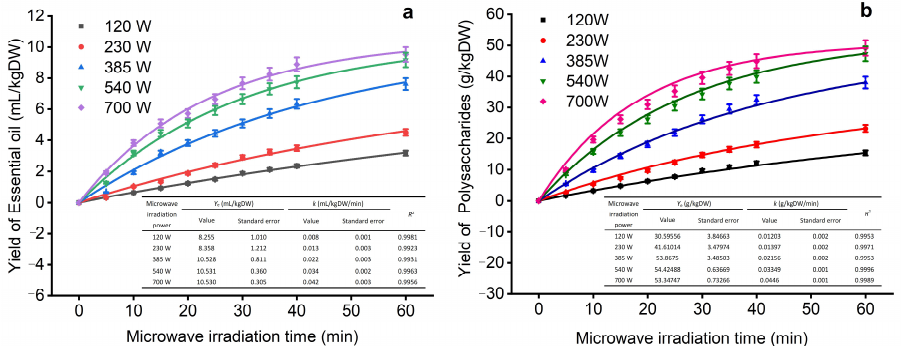
Figure 4. Extraction kinetic curve (The subfigures in the figure are correlation coefficient of the fitting curve; a: yield of essential oil; b: yield of polysaccharides).